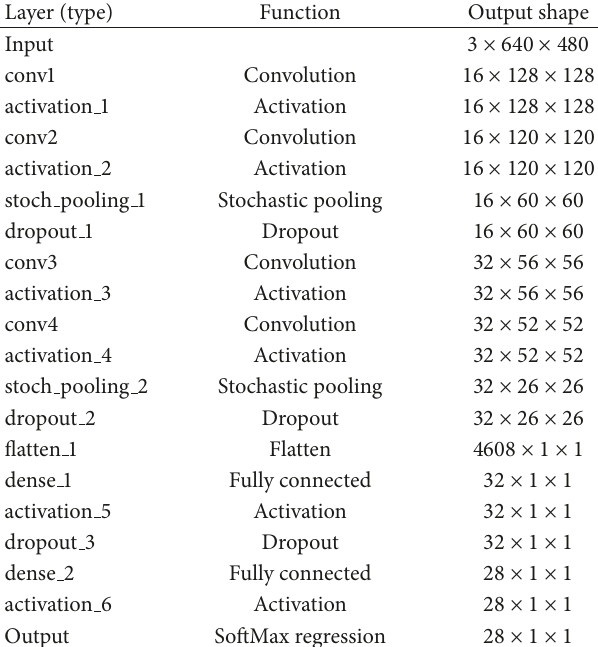
Table 1: Layer information and parameters of